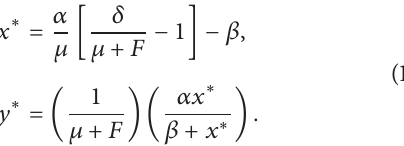
Note that if 𝑥 = 0 , then 𝑦 = 0 . Therefore 𝑃 0 = (0, 0) is a